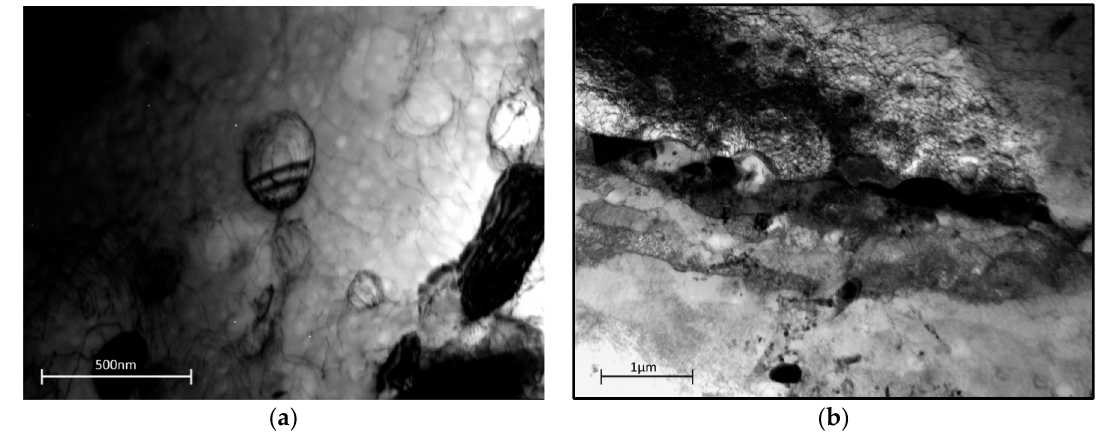
Figure 9. Dislocation structure in as-received Waspaloy material ( a ) within the grains ( b ) in the grain boundary zone.